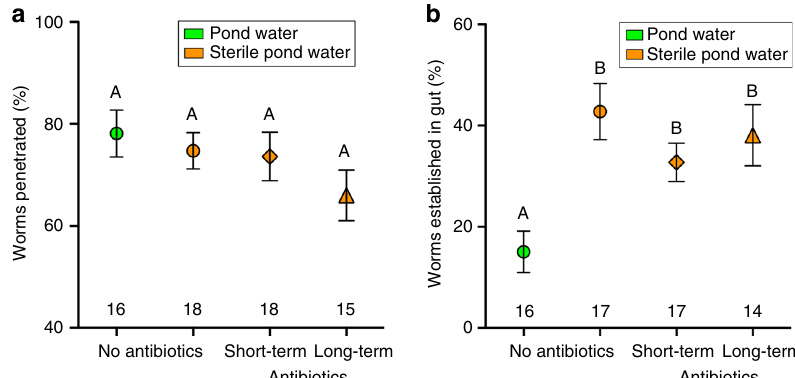
Fig. 4 Effect of juvenile water treatment on parasite penetration and establishment in adults. a Mean percent (%) of A. hamatospicula worms that penetrated the skin of adult frogs (GLMM, χ 2 = 3.08, df = 3, P = 0.38). b Mean percent (%) of A. hamatospicula worms that established in the guts of adult frogs ( χ 2 = 29.11, df = 3, P < 0.0001). Error bars indicate the s.e.m. Numbers directly above the x -axis tick marks are the number of replicates (tanks) per treatment. Treatments that do not share letters above the error bars are signi fi cantly different based on a sequential Bonferroni post hoc multiple comparison test ( P <